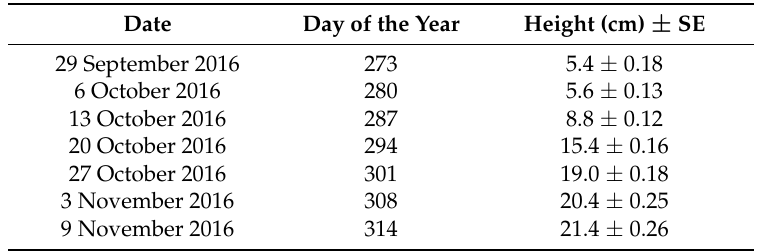
Table 3. Temporal evolution of lettuce height at the study site (average from 60 measurements per date and standard error,